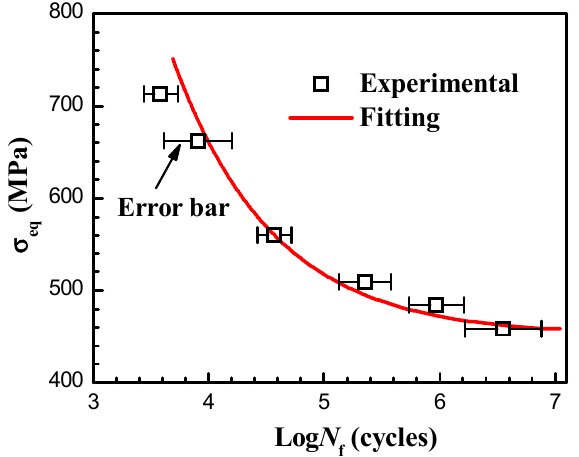
Figure 9. Testing results and fitting curve of tension–torsion fatigue lives under 90° non-proportional loading.